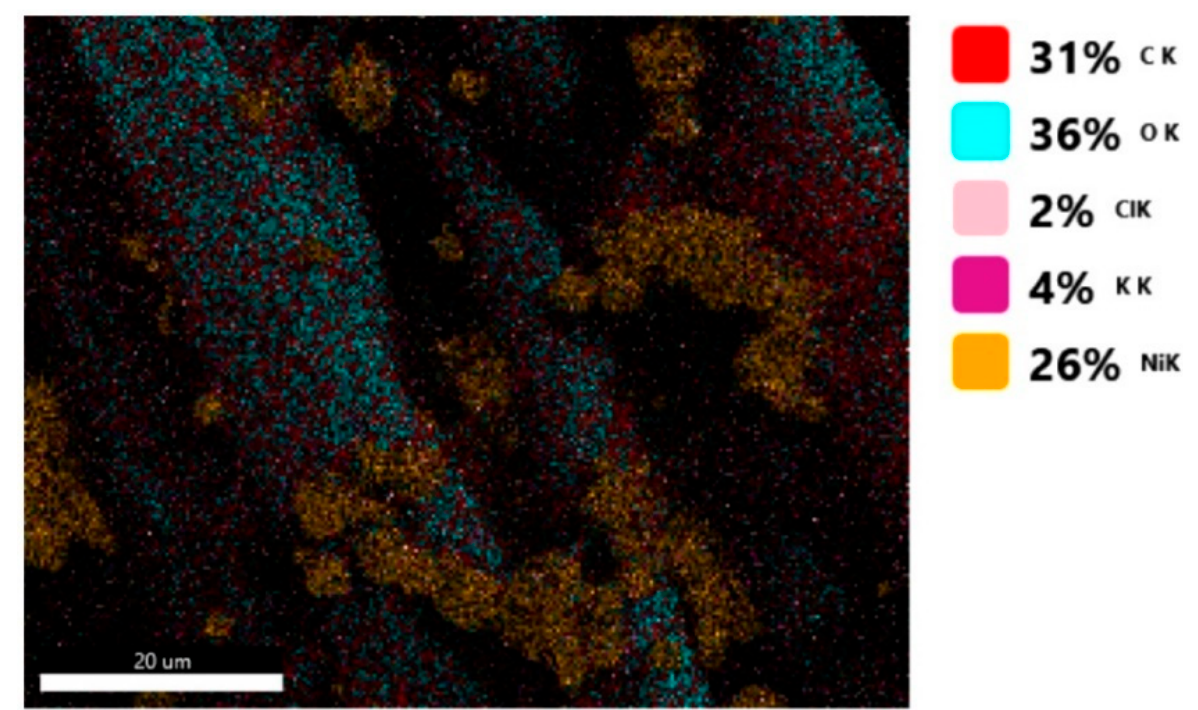
Figure 11. Smart elemental mapping overlay for sample S1 treated in RF plasma O 2 , using RF 2 generator and power 50 W and Ni paste.